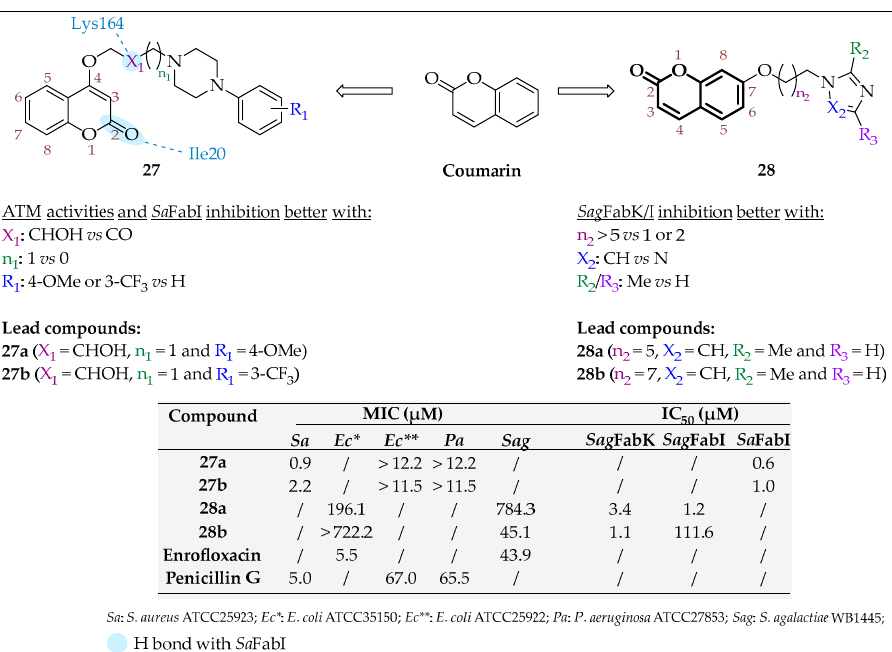
Figure 28. Structure, SAR and representation of main interactions with Sa FabI of coumarin derivatives 27–28 and in vitro activities of lead compounds [147,148]. In 2013, Belluti et al. coupled triclosan and coumarin to develop Pf FabI inhibitors [132]. Twelve compounds divided into two series of hybrids with the triclosan A ring in- serted at position 6 ( 29 , Figure 29) or position 7 ( 30 , Figure 29) of coumarin and a thirteenth compound ( 31 , Figure 29) with a phenyl linker between both units were designed. Inter- estingly, in compounds 29, alkyl chain substituents (R 1 ) at position 4 of the coumarin hy- brid decreased inhibitory activity while improving it in compounds 30 (R 2 ). Consequently, in the first series, the lead compound 29a was not substituted (R 1 = H), while the lead compounds of the second series 30a – b were methyl- or ethyl-substituted (R 2 = Me or Et). However, in both series, compounds with the best antiplasmodial activity were substi- tuted with ethyl at the position 4. Compound 31 (IC 50 ( Pf FabI) = 0.5 µM) was less cytotoxic than the others on mammalian L-6 cells. Docking studies showed that the triclosan A ring and coumarin ring of compounds 30 and 31 interact in the same way with Pf FabI. Indeed, the 5-chloro of triclosan A ring induced van der Waals interactions with Tyr267, Pro314 and Phe368. The coumarin-2-one group formed hydrogen bonds with Asn218 and Ala219.